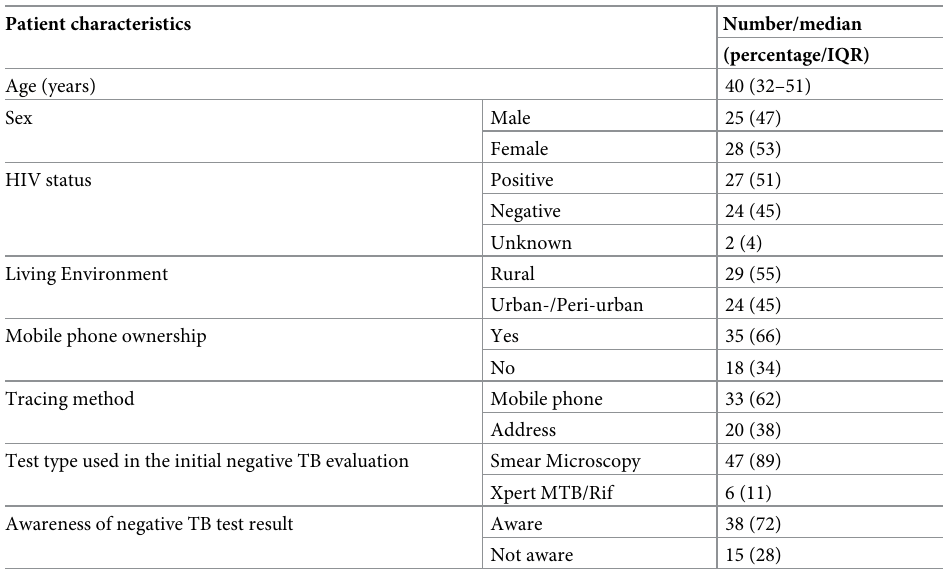
Table 1. Characteristics of surveyed